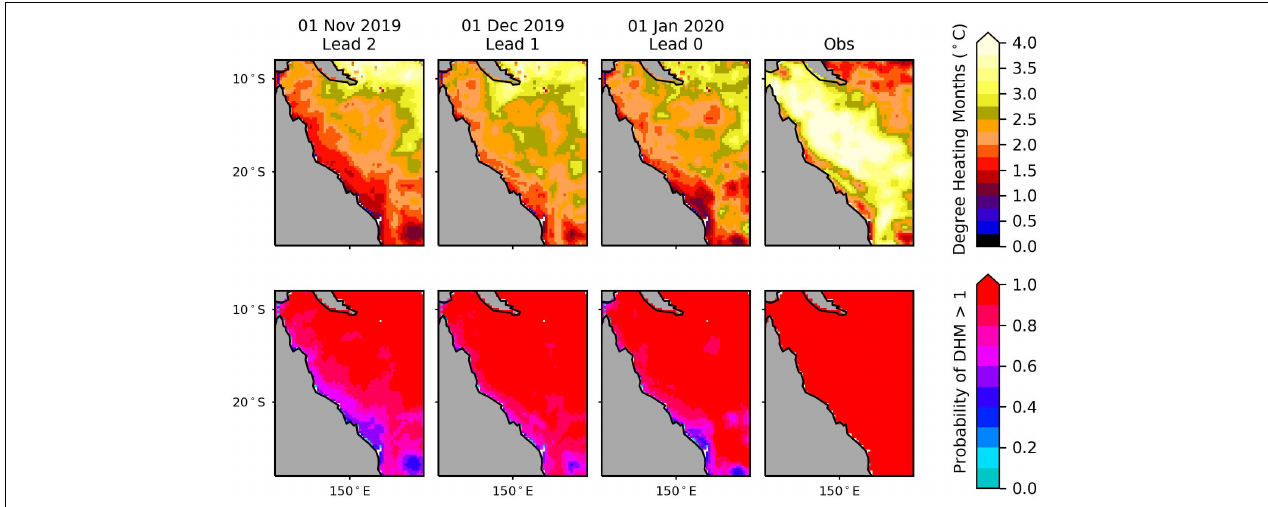
FIGURE 9 | Case Study 3: Realtime DHM forecasts for the GBR for January to March 2020 for model start dates 1 November 2019, 1 December 2019, and 1 January 2020. Top row is ensemble mean DHM, bottom row is probability of DHM > 1, using 99 ensemble members. Observed DHM values for January to March 2020 are shown in the far-right